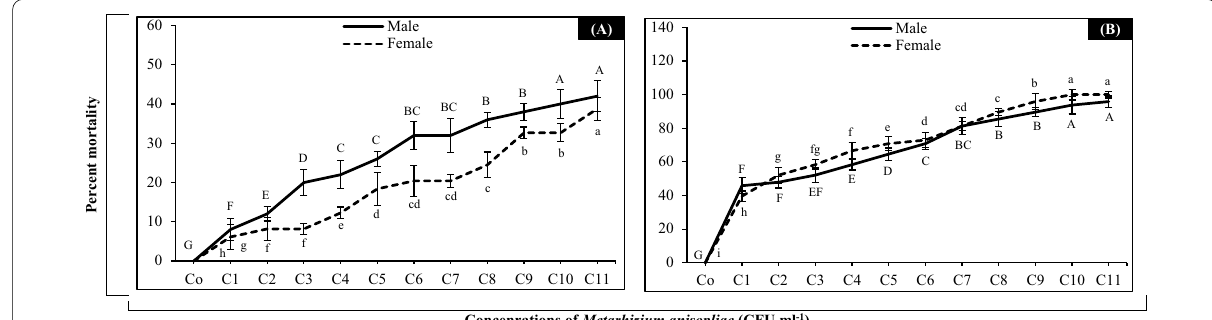
Fig. 1 Percent mortality of both sexes of Bactrocera zonata for different concentrations of Metarhizium anisopliae (solid and square-dotted lines represent mortality of male and female Bactrocera zonata , respectively; Capital and small letters represent mortality of male and female Bactrocera zonata , respectively) at 5 days post-exposure intervals (a) and 7 days post-exposure intervals (b) . Concentrations on x-axis represents C0 C1 1 10 3 CFU ml − 1 , C2 = × C7 1 10 6 CFU ml − 1 , C8 = × the standard error; means sharing similar style letters do not significantly differ at probability level of 5%. The mean values of lines (solid and ± square-dotted) bearing similar letters do not differ significantly